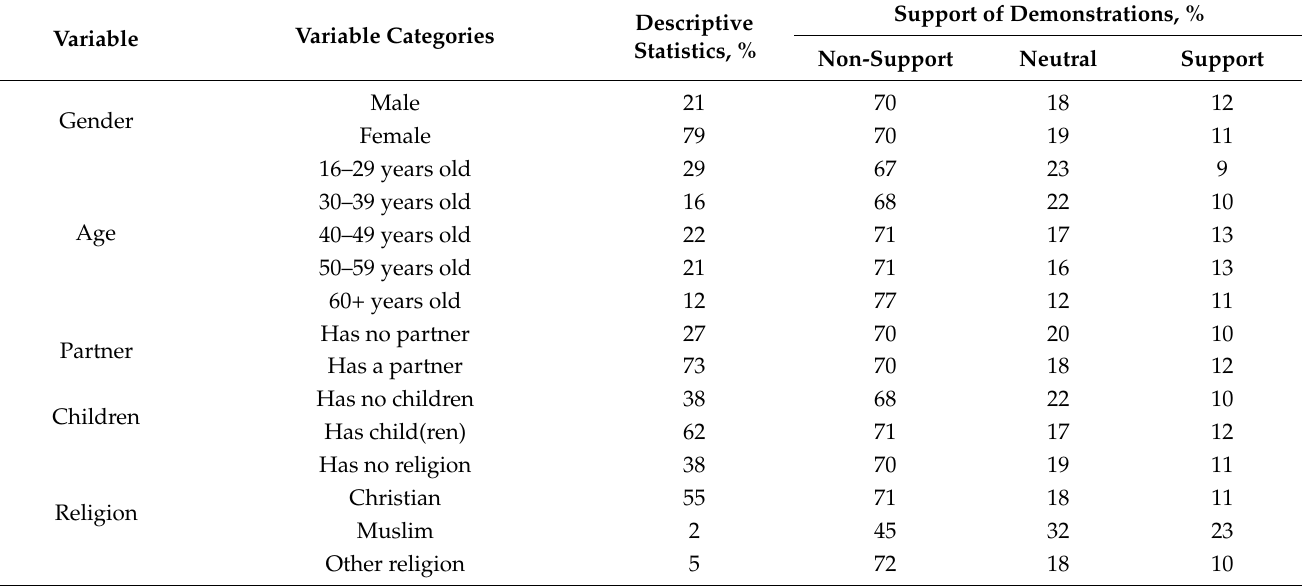
Table 3. Descriptive statistics and support of demonstrations by strata ( n =